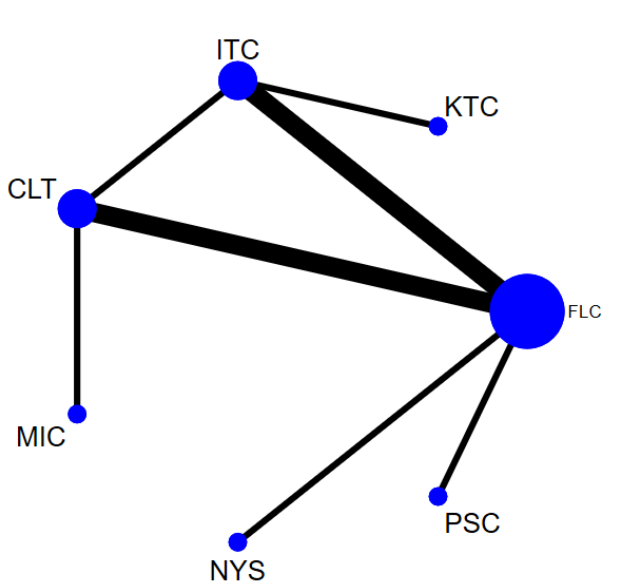
Figure 6. Network plot of trials comparing the efficacy of antifungal agents used for the treatment of OPC among HIV-infected adults (mycological cure). Abbreviations: